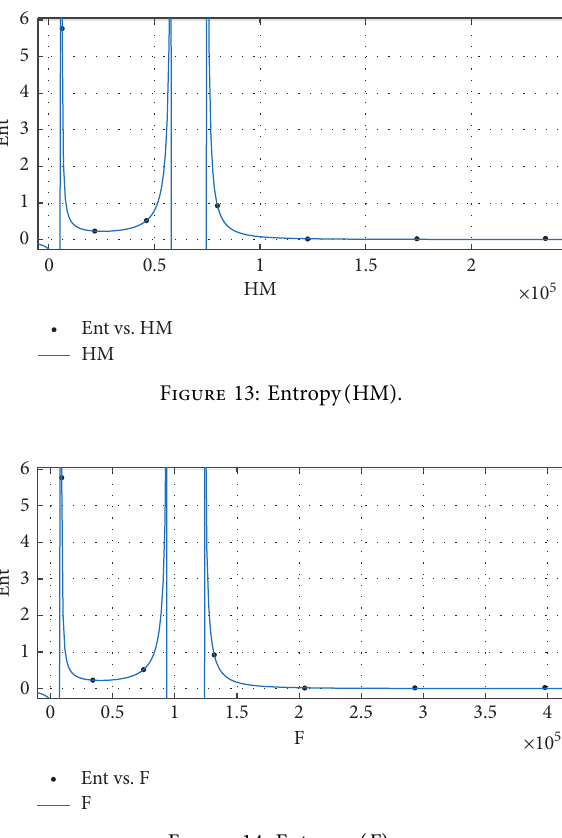
Figure 14: Entropy ( F ) .